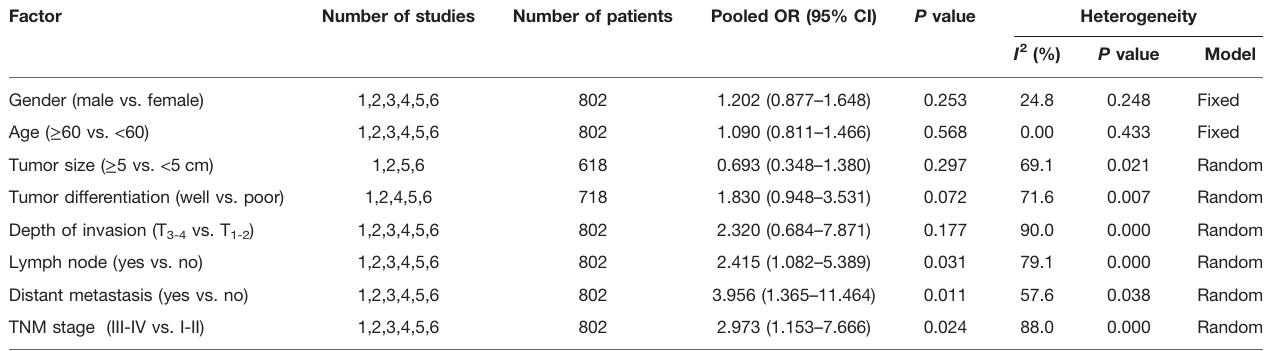
TABLE 2 | The association between USP22 expression and clinicopathological factors in GC. Factor